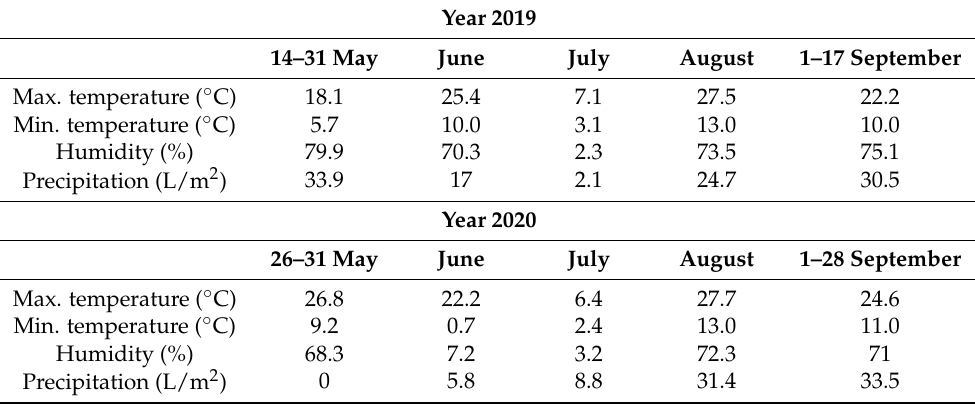
Table 4. Maximum and minimum temperatures, humidity and precipitation in the experimental field for years 2019 and